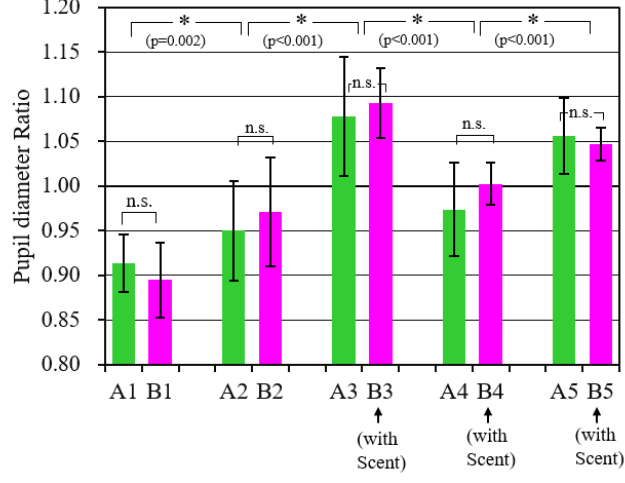
Figure 9. Comparison of pupil diameters during each scene.